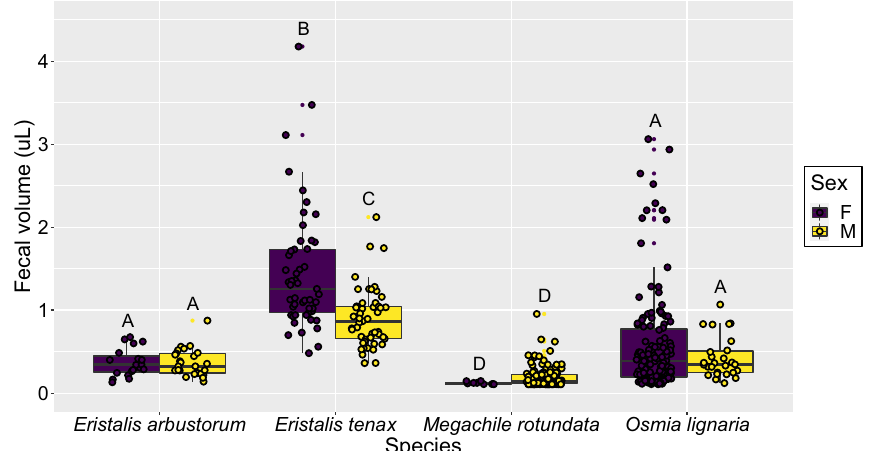
Figure 2. Fecal volumes of two flower fly pollinators, Eristalis arbustorum and E. tenax , and two bee pollinators, Megachile rotundata and Osmia lignaria . Whiskers indicate the range of fecal volumes, excluding outliers. Upper, middle and lower quartiles indicate the greatest, average and lowest fecal volumes collected, respectively. Data points have been jittered for clarity. Different letters indicate significant pairwise post-hoc contrasts ( p < 0.05).